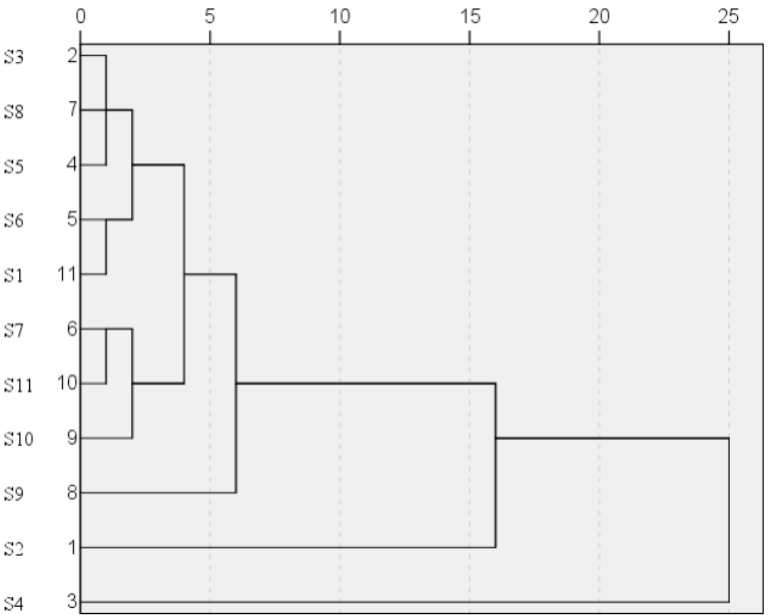
Figure 4. Hierarchical cluster analysis of S. chinensis.